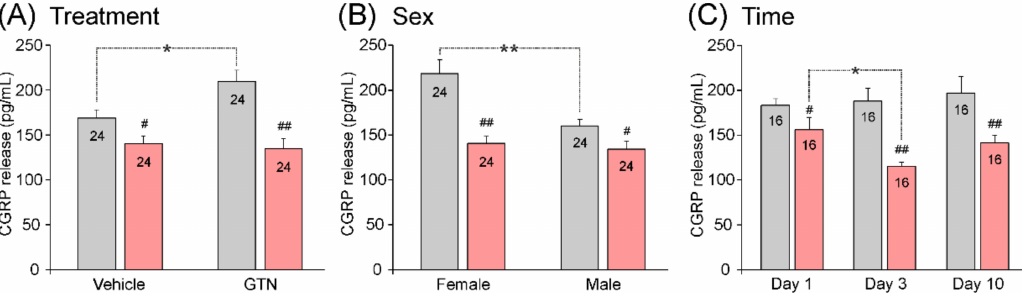
Figure 3. Stimulated CGRP release (mean ± SEM) from the dura mater of animals treated with control antibody (grey) or fremanezumab (red) depending on injection of vehicle or GTN ( A ), animal’s sex ( B ), and waiting time after antibody treatment ( C ). Numbers within columns denote counts of experiments; significant difference between groups (*: p < 0.05, **: p < 0.001) and between control antibody and fremanezumab (#: p < 0.05, ##: p <